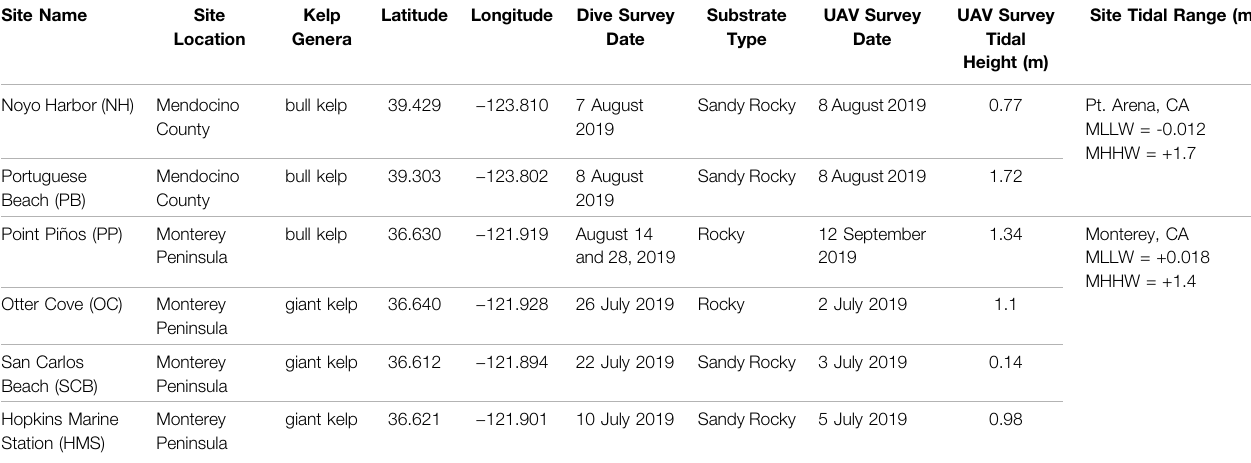
TABLE 1 | Detailed description of each survey location including region (Mendocino County or Monterey Peninsula), kelp genera, dive site coordinates, dive survey date, substrate type, UAV survey date, and mean tidal height during each UAV survey, survey site mean state (MLLW and MHHW) from Pt. Arena, CA and Monterey, CA